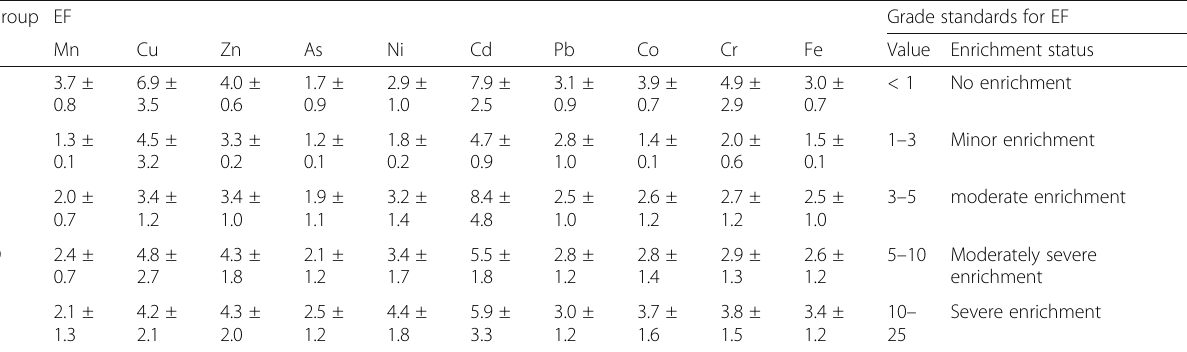
Table 5 Enrichment factor (EF) of heavy metals in sediments of lakes along a rural to urban gradient in central China and grade standards for EF (Birth 2003) Group EF Grade standards for